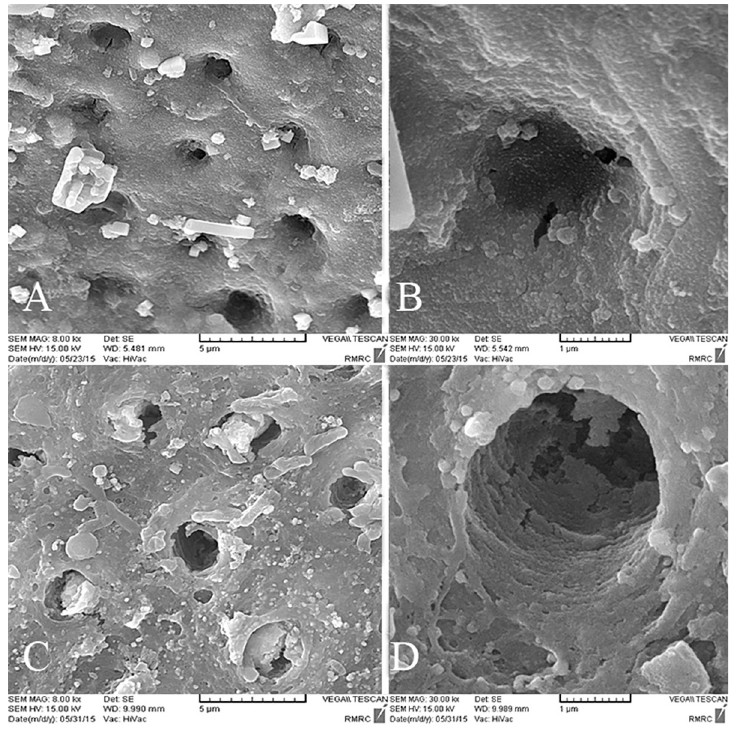
Fig 6. SEM images of the GSE+SDF group. A,B. Before acidic challenge. C,D. After Acidic challenge.